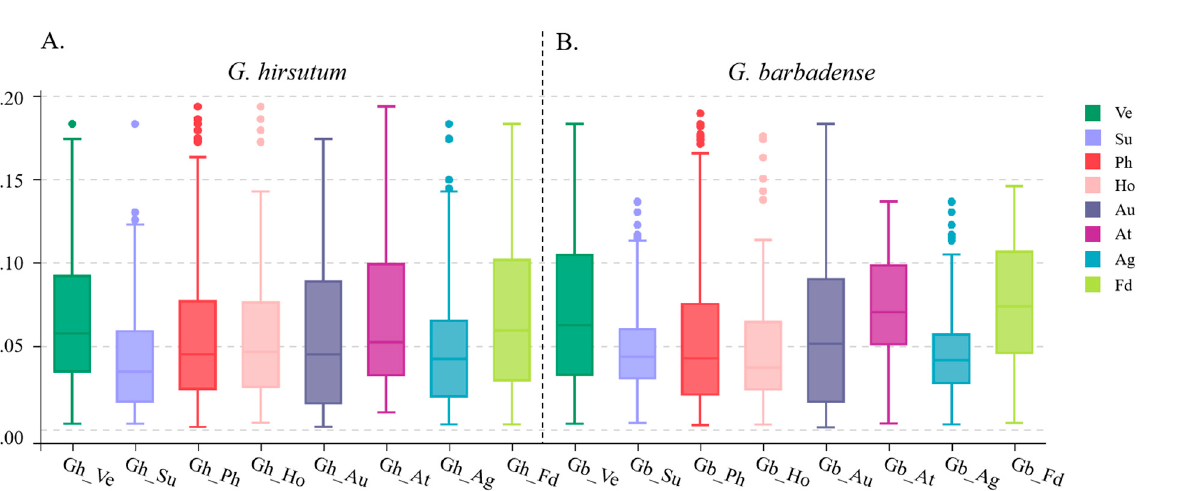
Figure 5. Direction and magnitude of natural selection acting on different flowering-related gene sets. Ka/Ks values of flowering-related genes in G. hirsutum ( A ) and G. barbadense ( B ). Quantile boxplots showing the distribution of Ka/Ks values for homologous gene pairs. Horizontal bars in each box indicate median values. Upper and lower bars correspond to the upper and lower adjacent values 1.5 times past the interquartile range. The outliers are plotted as discrete dots. Ve, vernalization; Su, sugar; Ph, photoperiod pathway, circadian clock, and light signaling; Ho, hormone signaling and metabolism; Au, autonomous pathways; At, ambient temperature pathway; Ag, aging pathway; Fd, flower development and apical meristem response pathway.